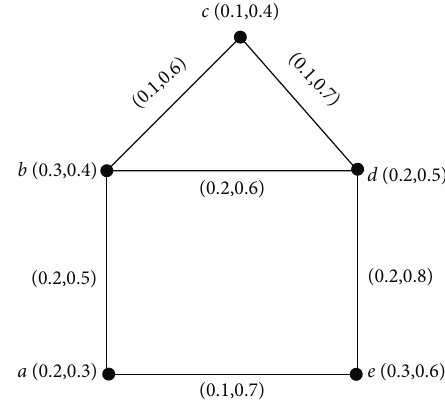
Figure 1: Vague graph ζ and its